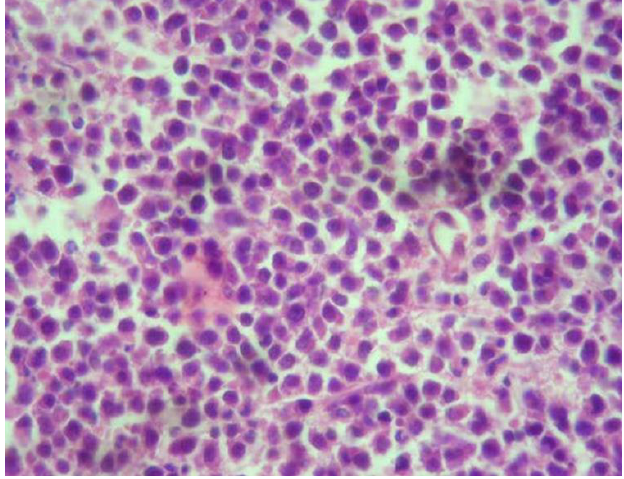
Fig. 5. The histopathological study, sheet-like pattern of atypical plasma cells.